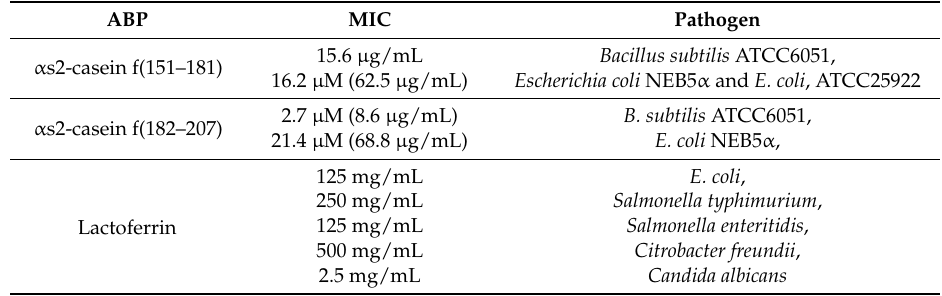
Table 2. Minimum inhibitory concentration (MIC) for different fragments of milk-derived ABPs (adopted from [60–63]).